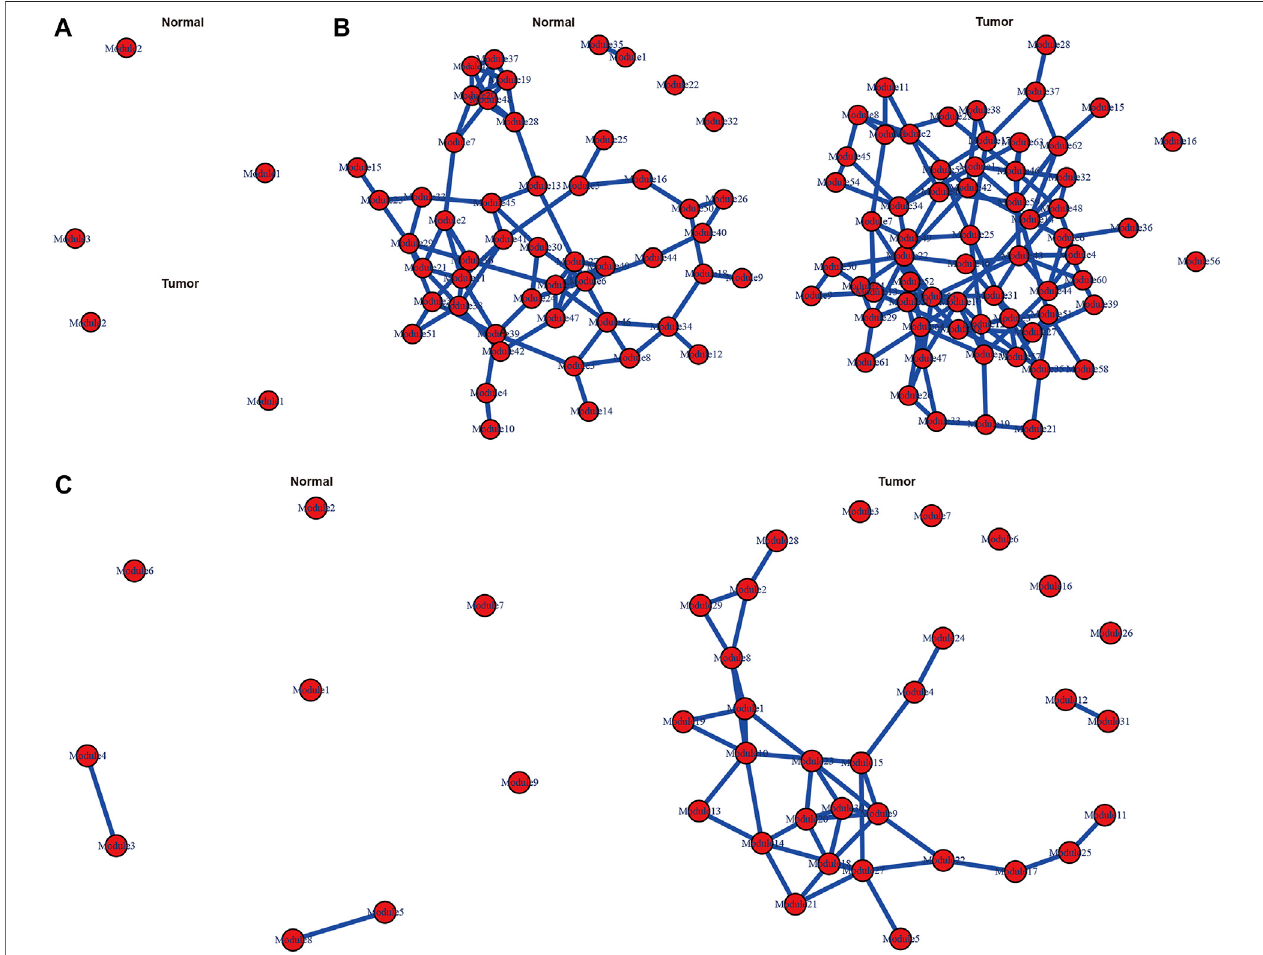
FIGURE 4 | Representations of the module network and differential co-expressions. Images of pink (A) , turquoise (B) and blue (C) module networks including cancerous and normal samples.